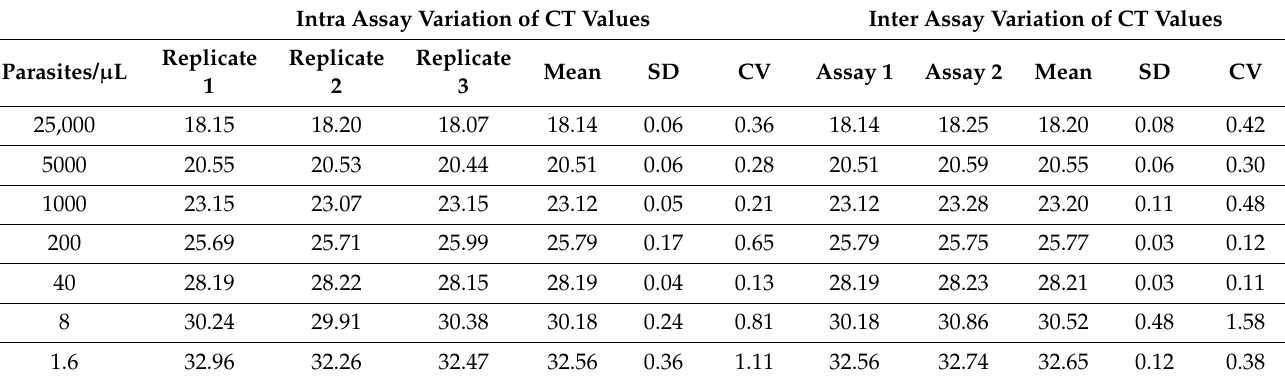
Table 2. Reproducibility and repeatability of real-time PCR assay for Pv . Intra Assay Variation of CT Values Inter Assay Variation of CT